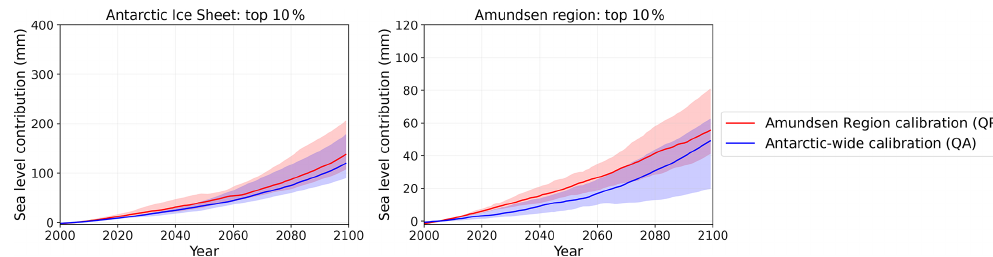
Figure A2. Similar as Fig. 7, but for the top 10% best-performing ESM-RF pairs.